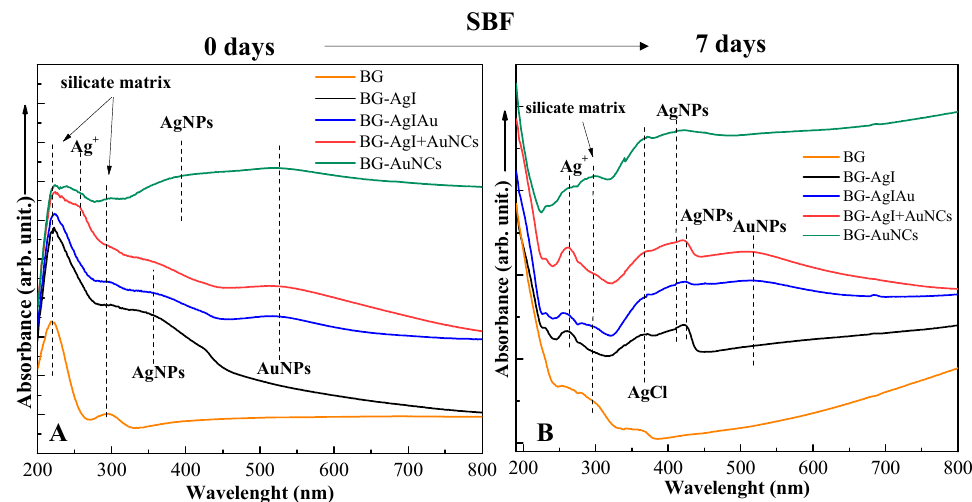
Figure 7. UV–Vis spectra of BG composites: ( a ) before (0 days) and ( b ) after (7 days) immersion in SBF. Table 3. Si, Ca, and P content of the heat-treated and immersed BG composites obtained from XPS measurements. For comparison, theoretical values were also